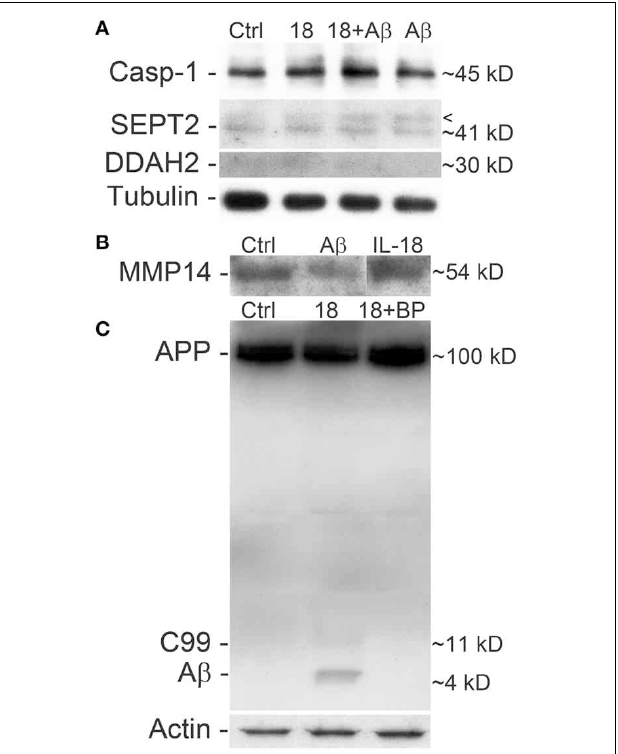
FIGURE 4 | Differentiated SH-SY5Y cells treated with IL-18 and/or A β 42 and blocked with IL-18BP. (A) Treatment with IL-18 (100ng/ml) or 1 μ M A β 42 increased caspase-1 expression, especially synergistically at 72h. SEPT2 analysis showed an extra band above the 41kD main band, which is particularly strong in A β 42 treated cells and IL-18 + A β 42 treated cells, compared to untreated control. Although the results of DDAH2 are faint, they indicate increased DDAH2 in IL-18 treated cells whereas treatment with IL-18 + A β 42, and particularly A β 42, seemed to reduce its levels vs. control. Tubulin was a loading control. The results are from the same membrane. The appearance of these cells is shown in our previous paper (Sutinen et al., 2012). (B) 1 μ M A β 42 decreased soluble MMP14 levels in the SH-SY5Y culture medium. (C) IL-18 at 100ng/ml treatment for 72h also increased APP processing to C99 and A β , which was blocked by 0.5 μ g/ml IL-18BP. Actin was used as a loading control.